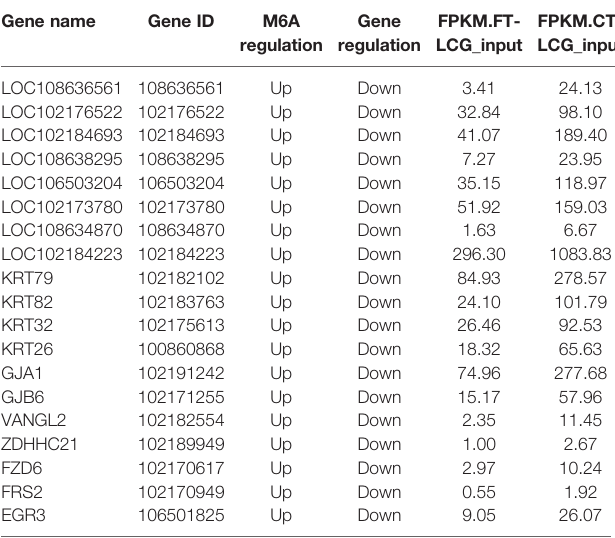
TABLE 5 | Candidate m6A modi fi ed genes related to cashmere fi